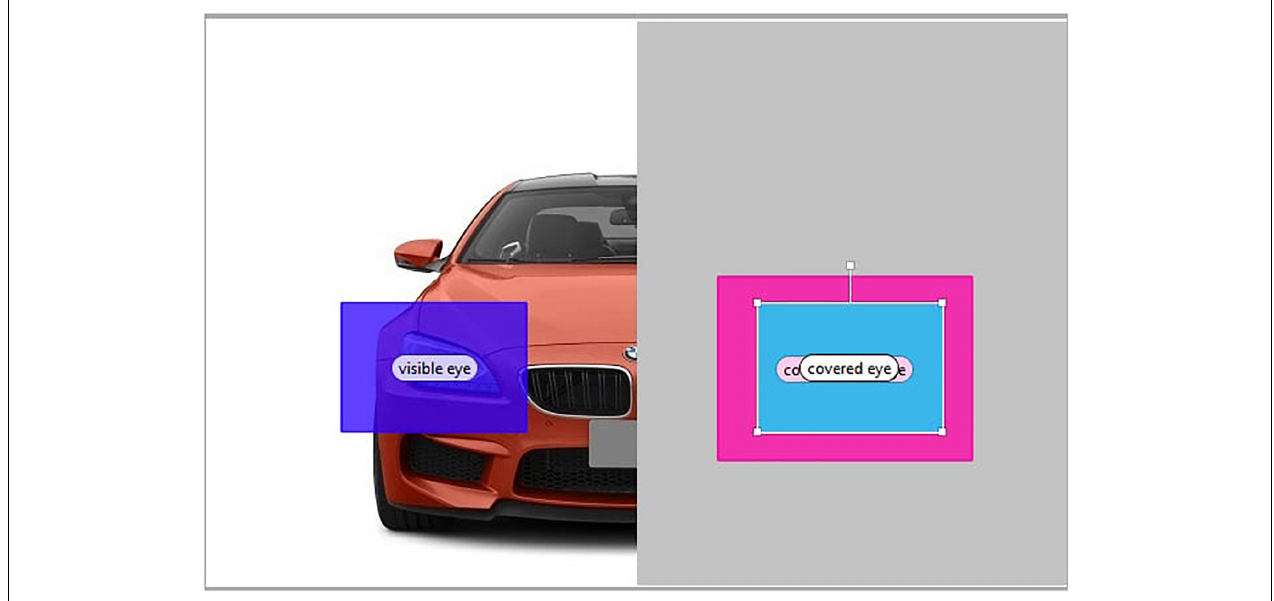
FIGURE 8 | Areas of interest for a car